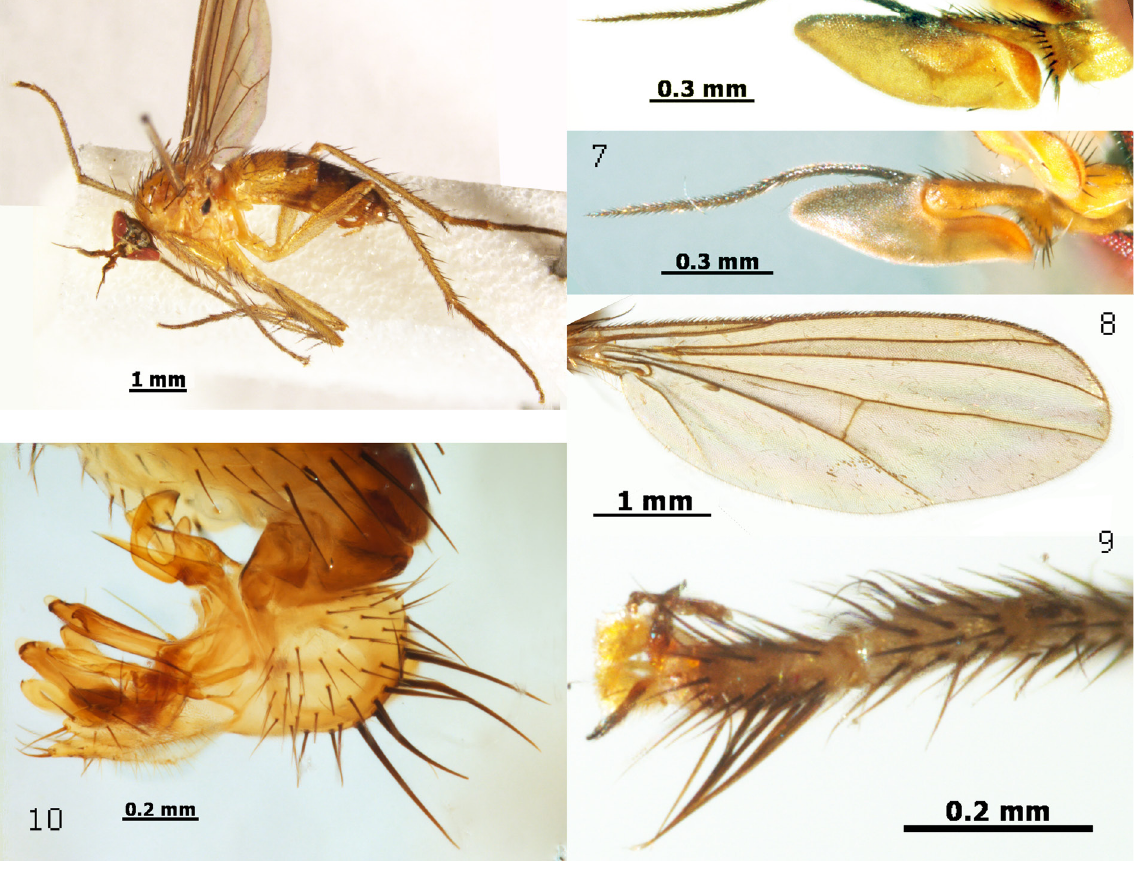
Figs 5–10. Dactylonotus tsitsikamma sp. nov., ♂. 5 . Habitus. 6 . Antenna, outer lateral view. 7 . Antenna, inner lateral view. 8 . Wing. 9 . Apical segments 4–5 of fore tarsus. 10 . Hypopygium after maceration, left lateral